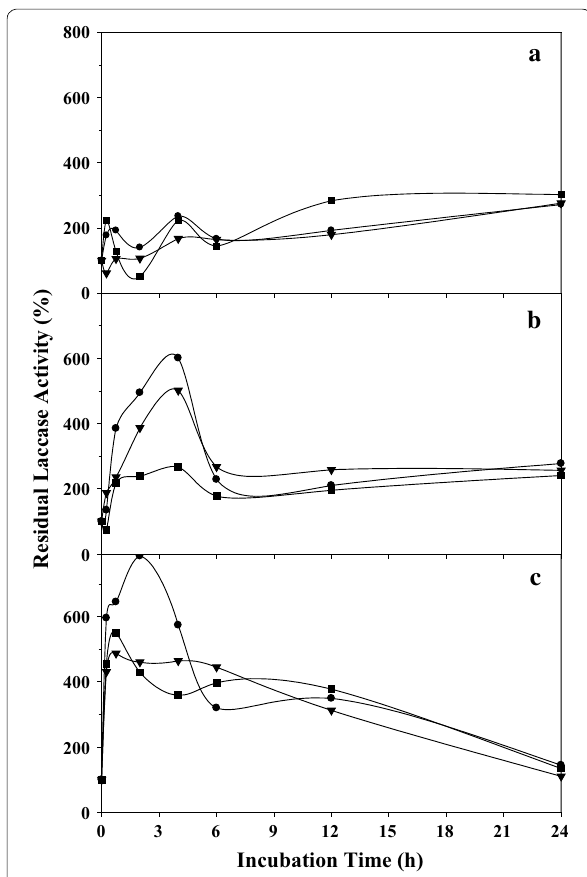
Fig. 4 The thermostability profiles of the residual laccase activity in the lyophilized enzymatic extract from Coriolus hirsutus , after incubation at a 4, b 25 and c 50 °C. The reaction mixture contains the enzymatic preparations including the control being the lyophilized enzyme without additive (black circle) with 2.5% (w/v) mannitol (black down‑pointing triangle) and 2.5% (w/v) dextran 15 to 25 kDa (black square) as additive. The residual laccase activity (%) was defined as the specific activity of each treated enzyme extract at a defined temperature and time in comparison to that at time zero of